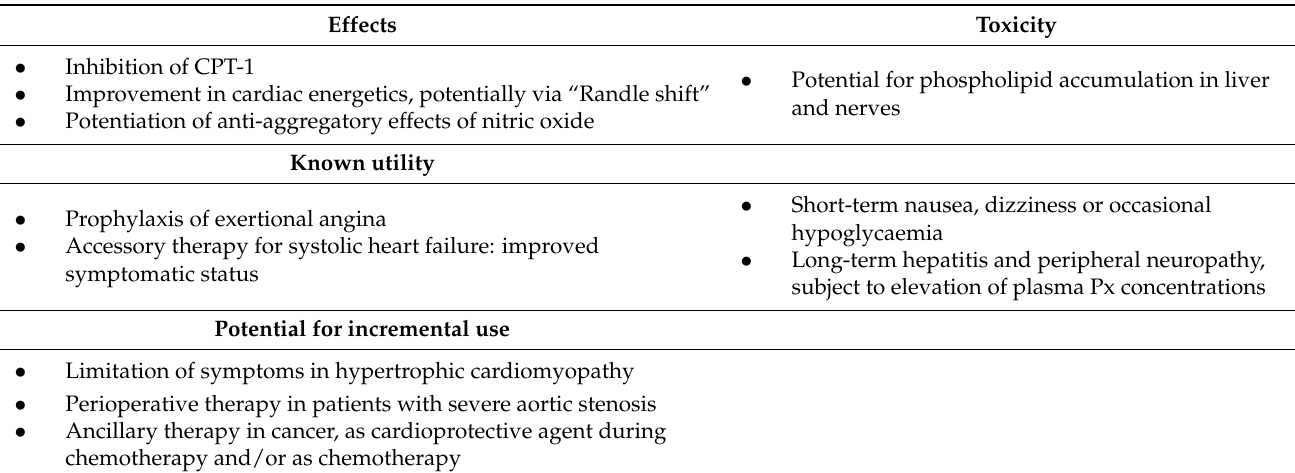
Table 3. Perhexiline: current “State of the art” regarding its biochemical actions, utility &